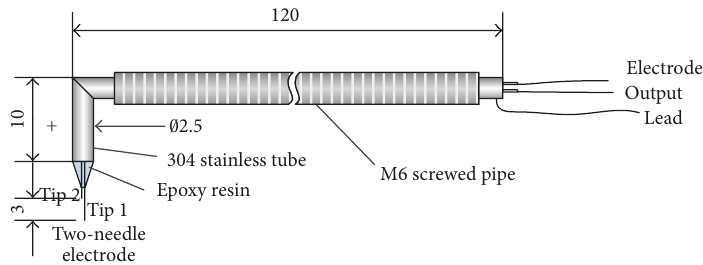
Figure 7: Schematic diagram of the capacitance probe.